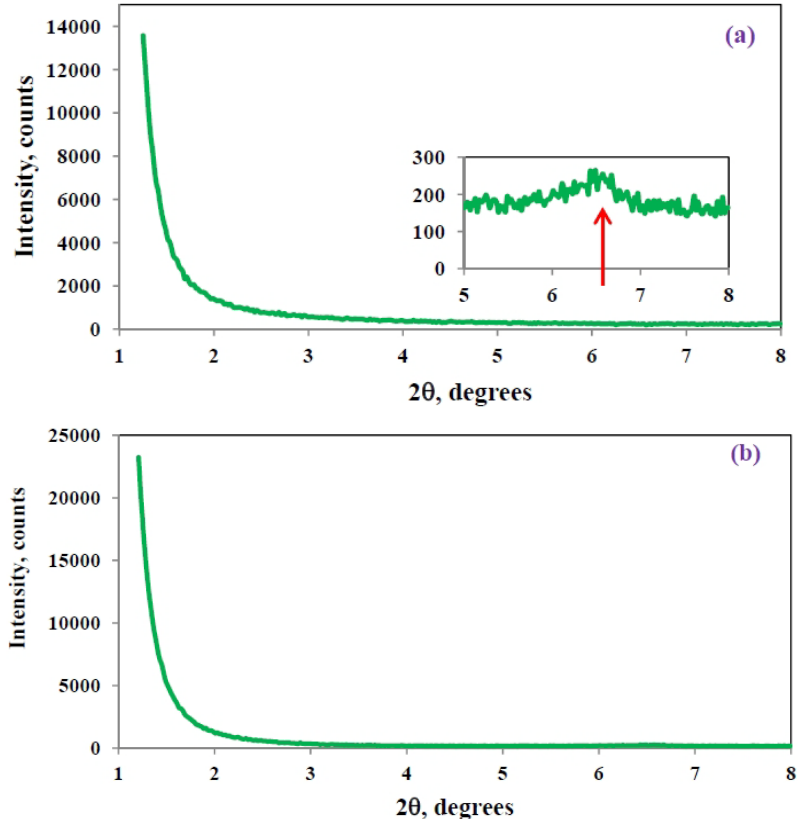
Figure 6. Typical SAXS diffractograms for nanocomposites: ( a ) for sample 5%, 180 °C; ( b ) for sample 2% + 0.5% BF , 150 °C. The inset shows the small peak at 6.5 nm on an 3 enlarged scale.